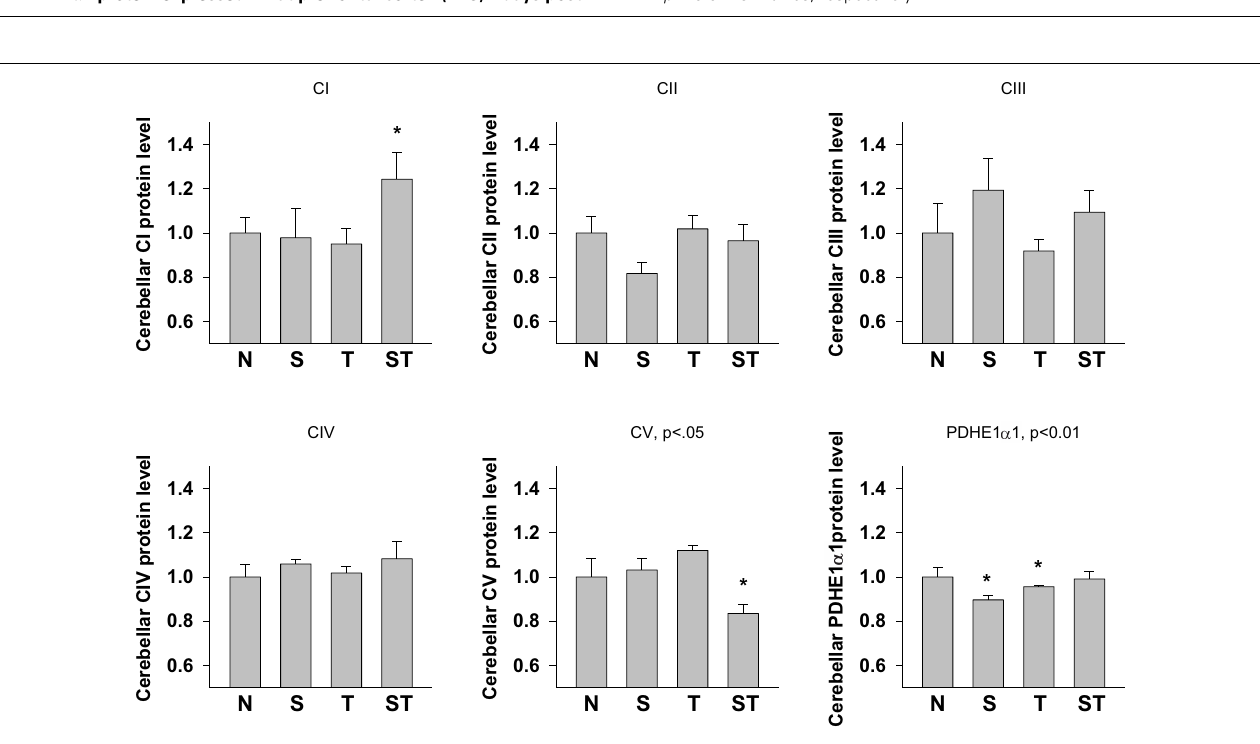
mTBI . N, Naïves; S, Stress;T, mTBI; ST, stress followed by mTBI. Results are presented as the fold change relative to the Naïves ( = 1). * p < 0.05, ** p < 0.01 vs. Naïves, respectively.